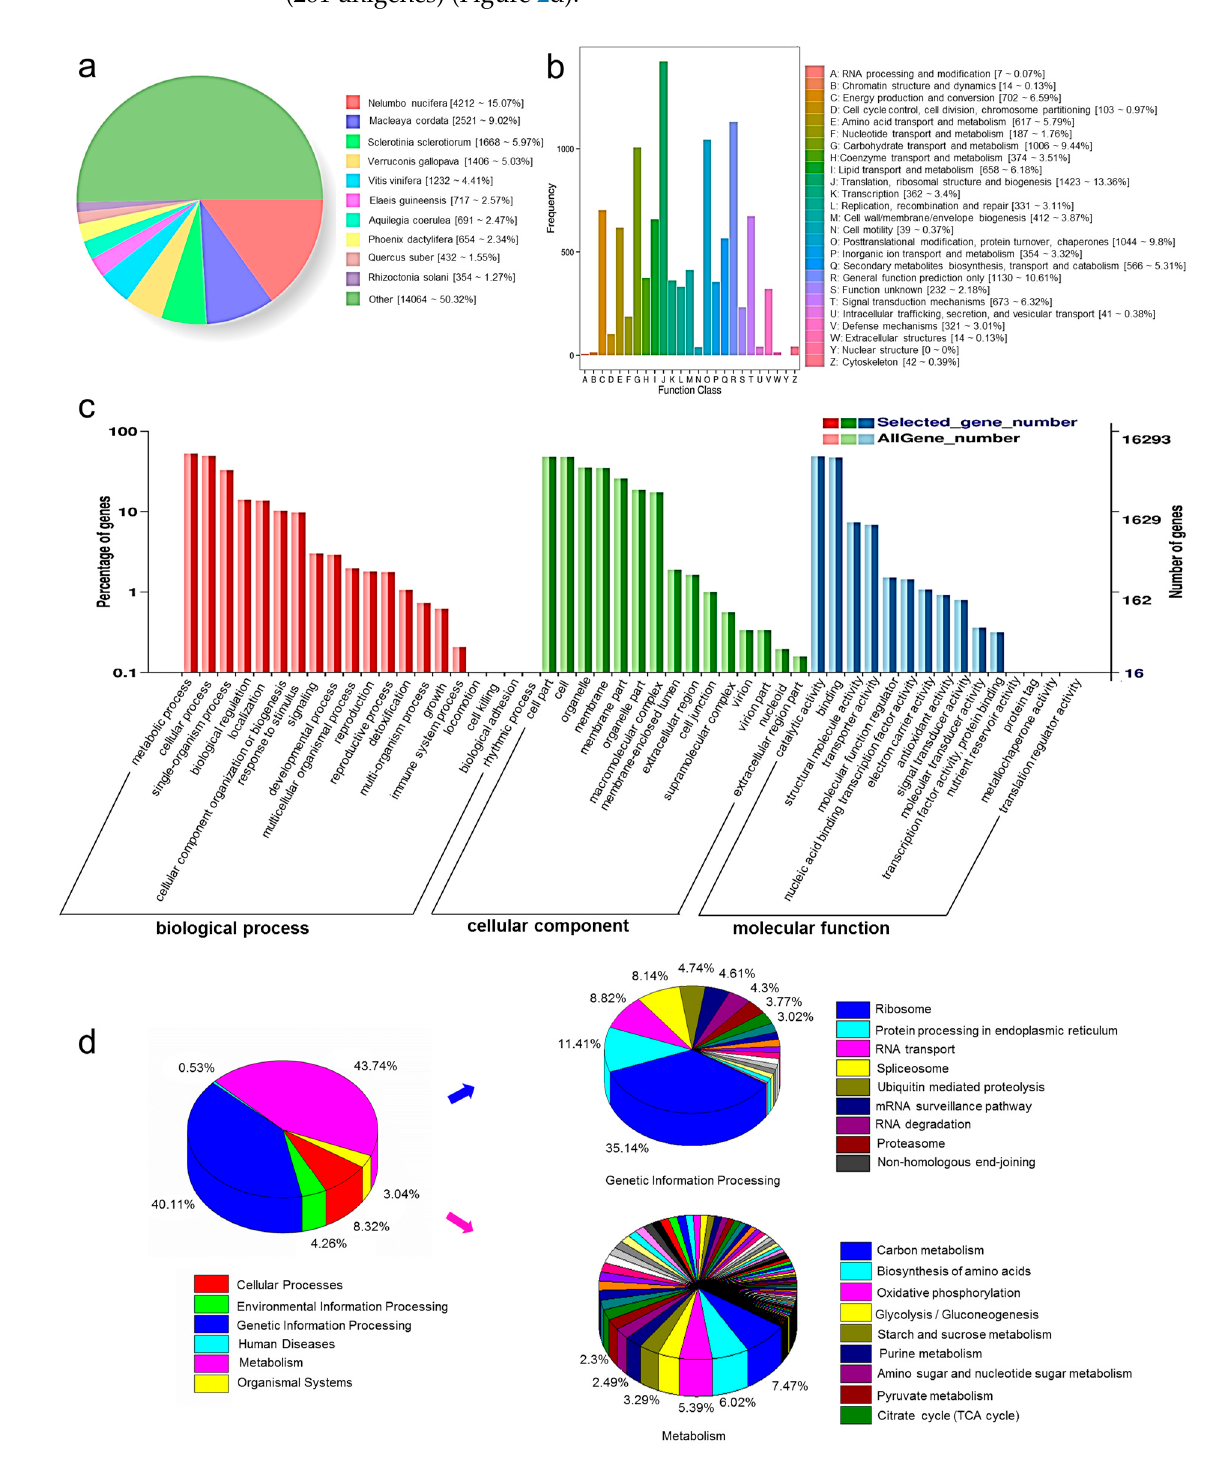
Figure 2. NR annotated species distribution and functional annotation of unigenes. ( a ) BLAST top hit species distribution, ( b ) COG classification, ( c ) GO classification and ( d ) KEGG pathways classification.